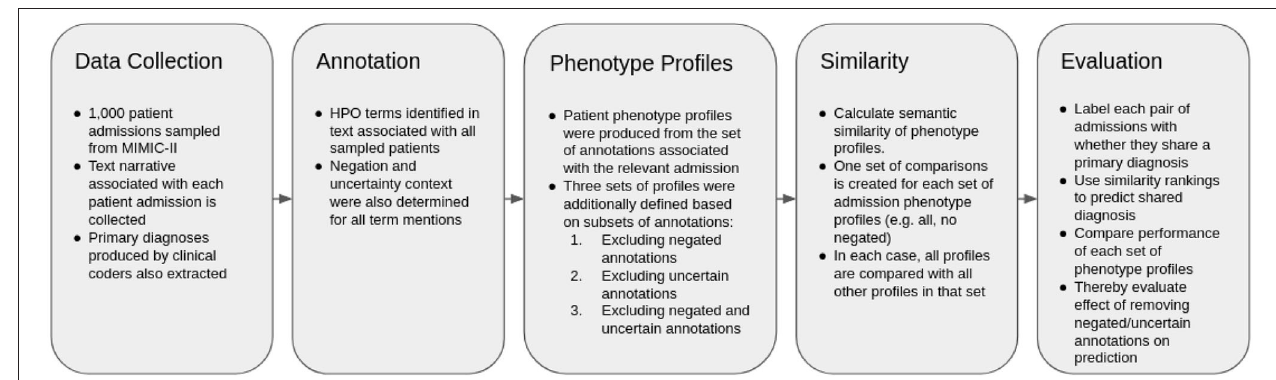
FIGURE 1 | Flow chart describing the experimental